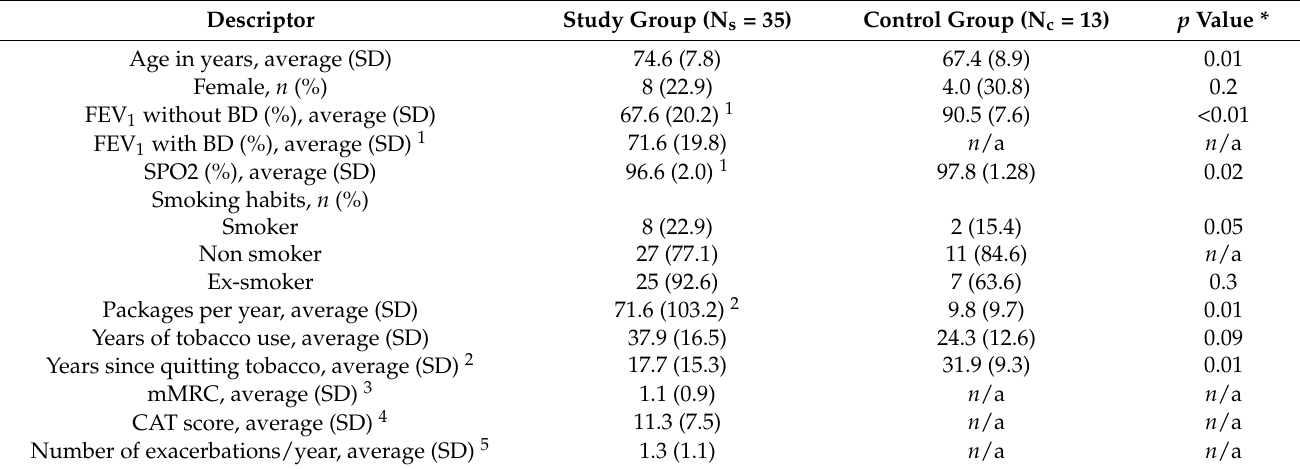
Table 2. Characteristics of the